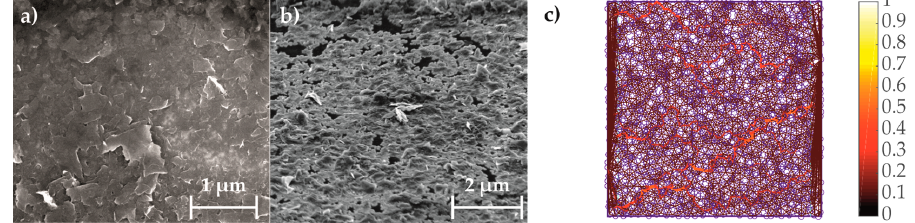
Figure 5. ( a ) SEM image of GNP coating (top view); ( b ) SEM image of GNP coating (52° inclined view); ( c ) numerical 2D-model with high density of randomly distributed GNP and the main conductive paths (highlighted in yellow-red) [49].